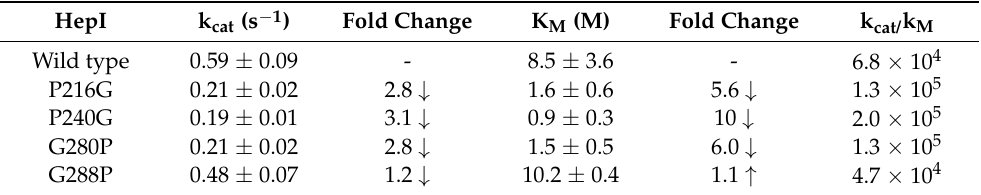
Table 1. Kinetic constants for the site-directed mutagenesis HepI.